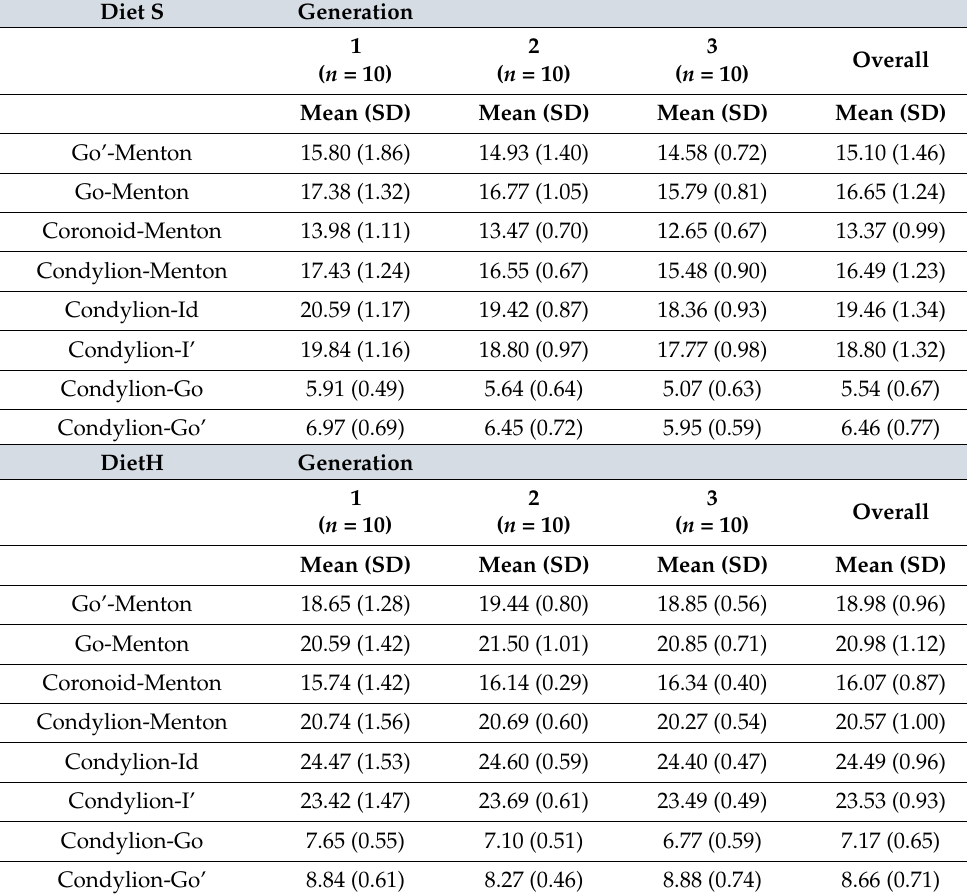
Table 5. Results for all variables measured, means, and standard deviations.